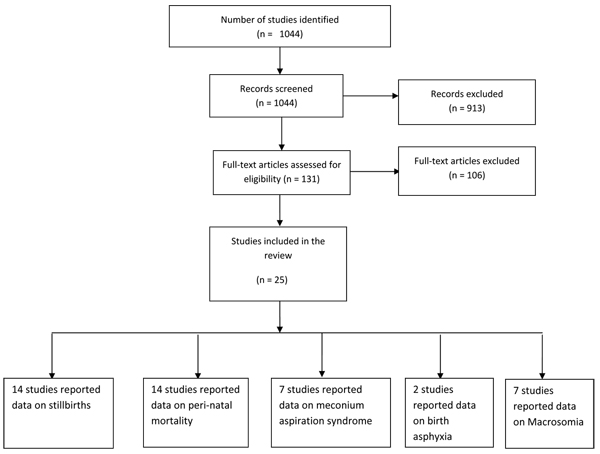
Flow diagram showing identification of studies evaluating induction of labor at or beyond 41 weeks